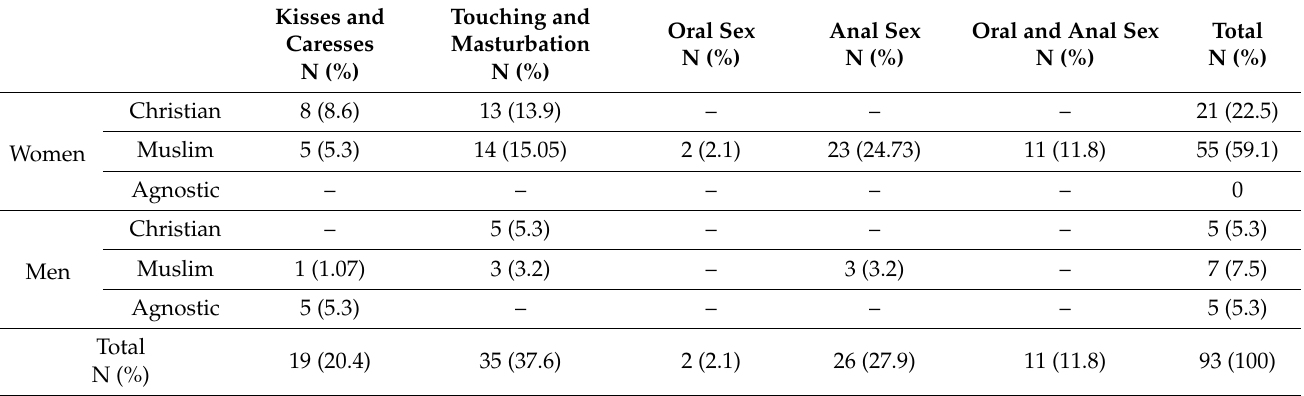
Table 3. Sexual practices not considered to interfere with the participants’ concept of virginity according to sex and religion